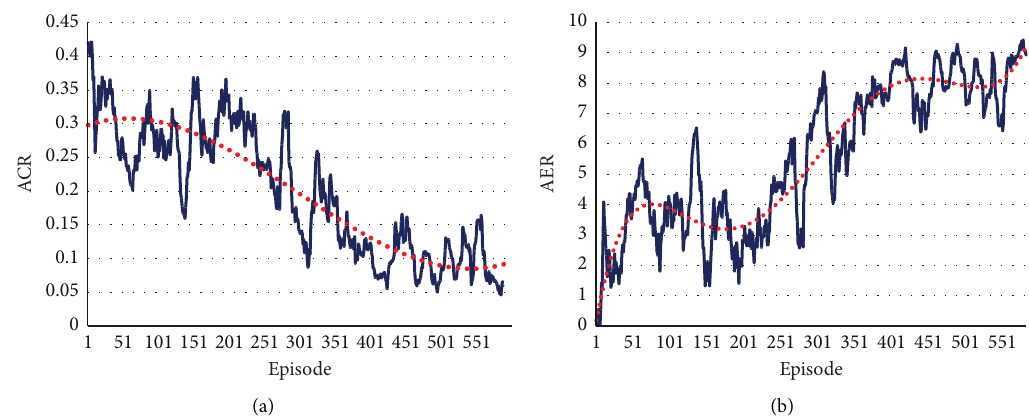
Figure 6: ACR and AER with respect to episodes after processing with diferential fltering.(a) ACR. (b)